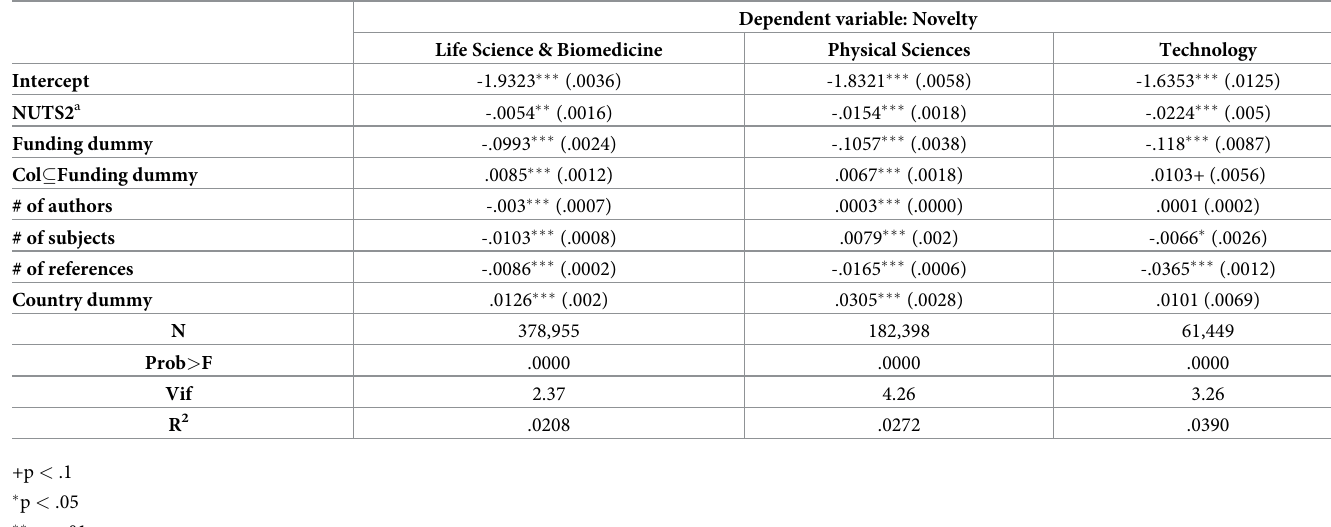
Table 6. Robustness